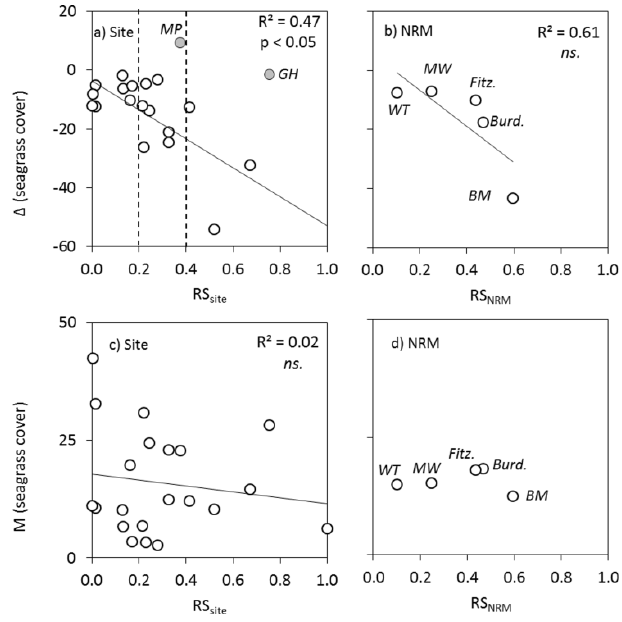
Figure 8. Multi-annual (2005–2014) changes in ( Δ : a , b ) and mean (M: c , d ) seagrass cover compared to risk scores (RS) at the: site ( left ) and NRM scales ( right ). Determination coefficient and p values of ( a ) are calculated without considering Midge Point (MP) and Gladstone Harbour (GH): grey dots. WT: Wet Tropics, MW: Mackay Whitsunday, Fitz.: Fitzroy Burd.: Burdekin and BM: Burnett-Mary. The dotted line in ( a ) indicates three risk score thresholds (I: ≤ 0.2, II: 0.2–0.4 and III: >0.4) associated with a gain or little loss in seagrass cover (gain/ − 12%), with moderate loss ( − 12/ − 30%) and with the greatest loss in seagrass % cover (> − 30%), respectively.